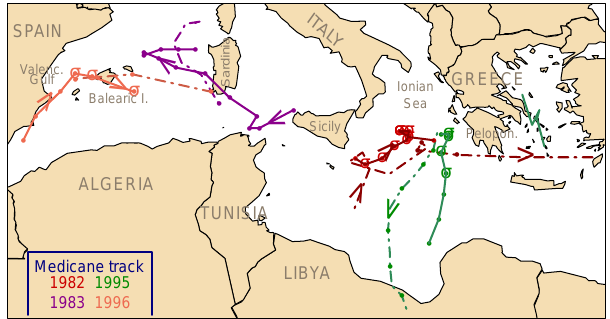
Fig. 1. Medicane tracks in Mediterranean Sea. In red, 1982 event, in violet, 1983 event, in green 1995 event and in orange 1996 event. Simulated cyclone tracks (solid lines) with symbol σ indicates med- icane + observed cyclone tracks transcribed from literature (dot- dash